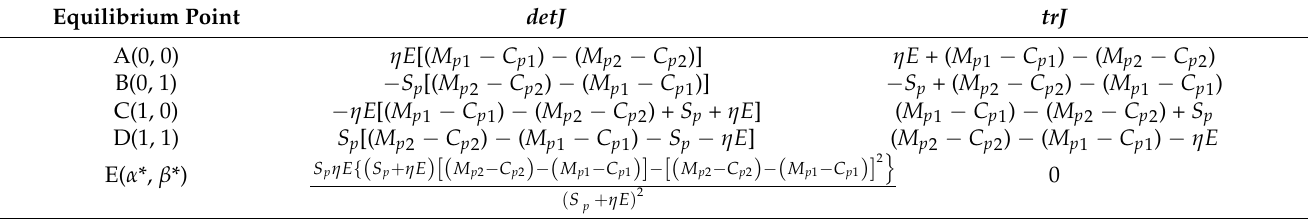
Table 9. The analysis table for judging the stability of equilibrium points between local government and the